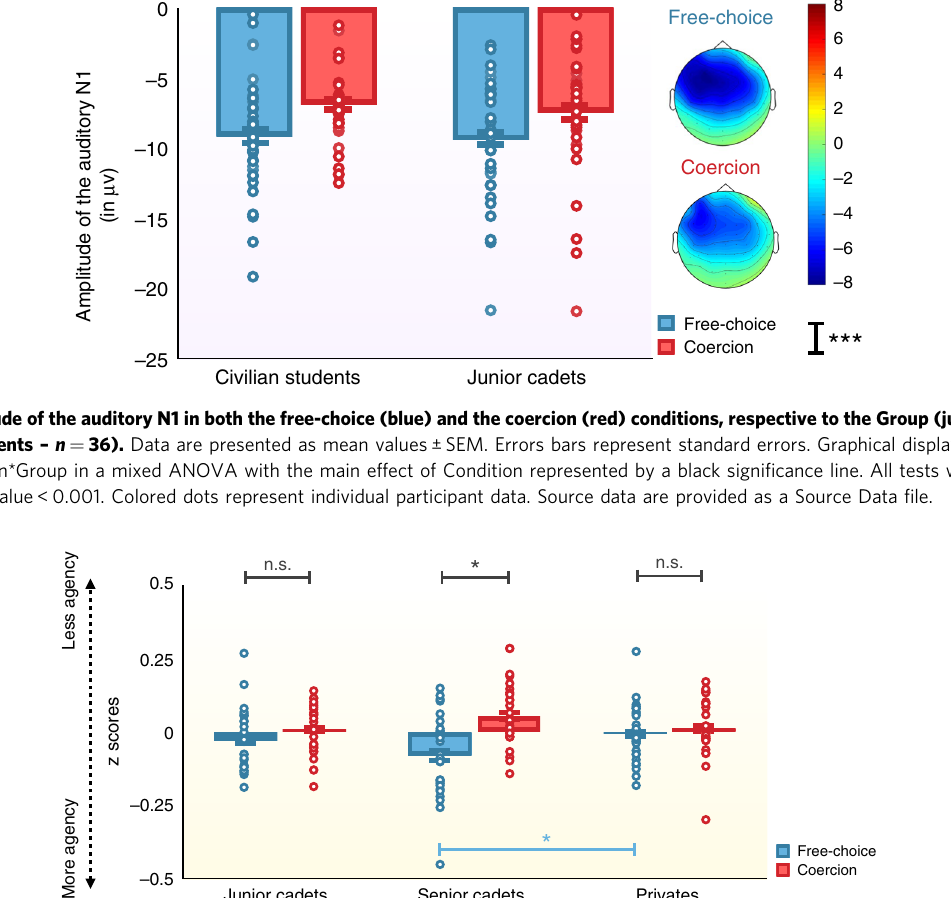
Fig. 3 z -scored interval estimates, used as an implicit measure of sense of agency, in free-choice (blue) and coercion (red) conditions for the three groups: junior cadets ( n = 28), seniors ( n = 30), and privates ( n = 27). Data are presented as mean values ± SEM. Errors bars represent standard errors. Graphical display showing the interaction Condition*Group in a mixed ANOVA with independent (red, blue signi fi cance lines) and paired (black signi fi cance lines) sample t -tests. All tests were two-tailed. *** represents a p -value ≤ 0.001. * represents a p -value between 0.01 and 0.05. n.s. indicates a non-signi fi cant result. z -scores were lower in the free-choice condition for senior cadets than for privates ( p = 0.025). Colored dots represent individual participant data. Source data are provided as a Source Data fi